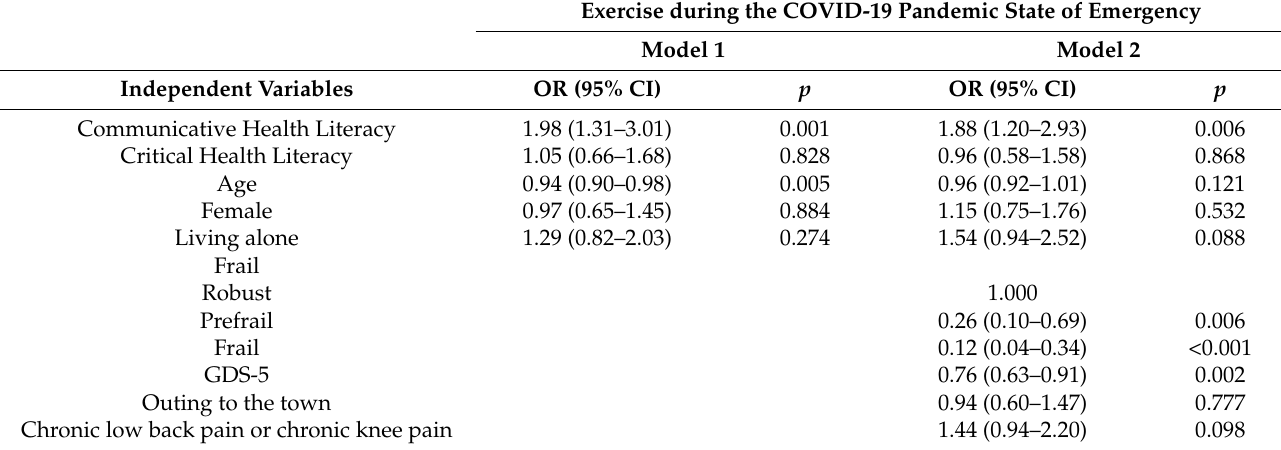
Table 2. Associations of exercise during the COVID-19 pandemic state of emergency with health literacy. Exercise during the COVID-19 Pandemic State of Emergency